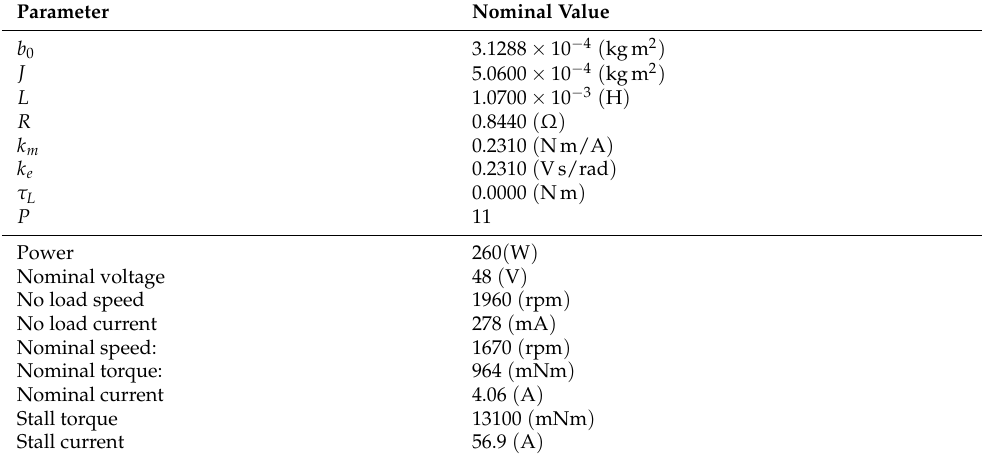
Table 3. Nominal parameters and characteristics of the BLDC motor obtained from the maxon flat brushless motor EC 90 with part number